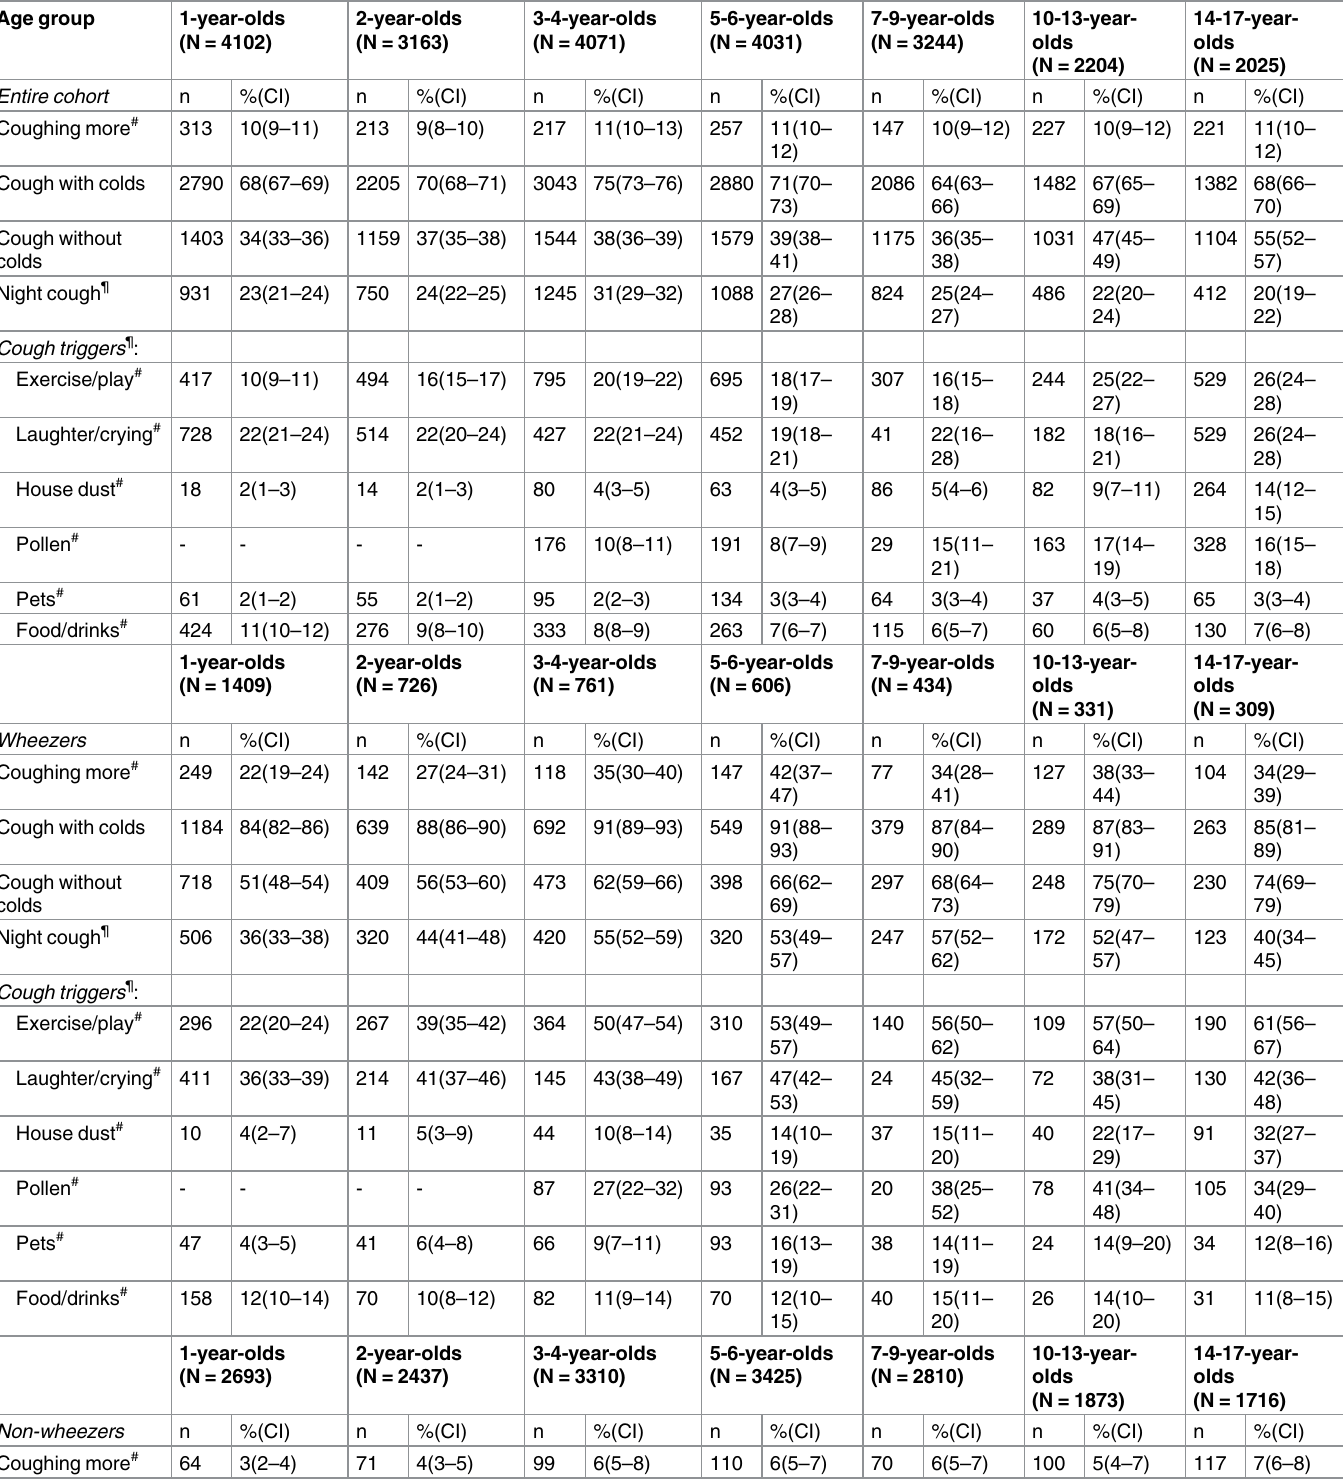
Table 3. Prevalence of cough in different age groups in the entire cohort, and separately for children with and without wheeze. Age